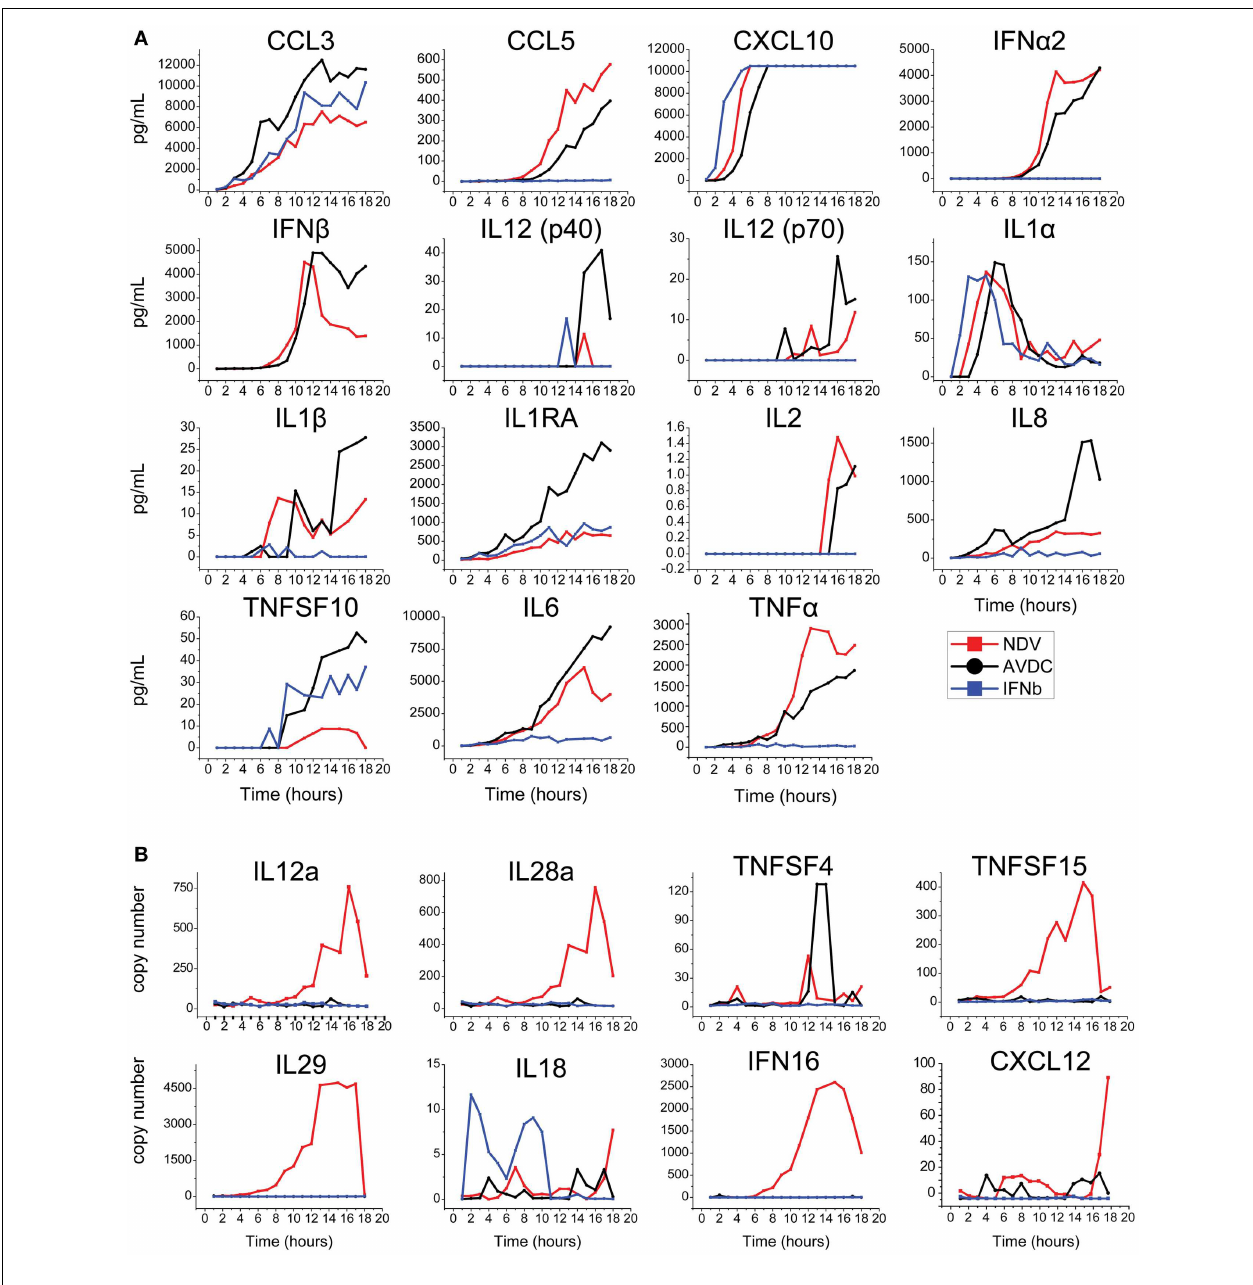
AVDC (black line) indicates measurements from supernatants from infected and co-cultured naïve DCs at a 1:1 ratio (ELISA) or naïve DCs which were co-cultured with infected cells (PCR). IFN β (blue line) indicates measurements from supernatants (ELISA) or cells (PCR) from naïve DCs exposed to IFN β